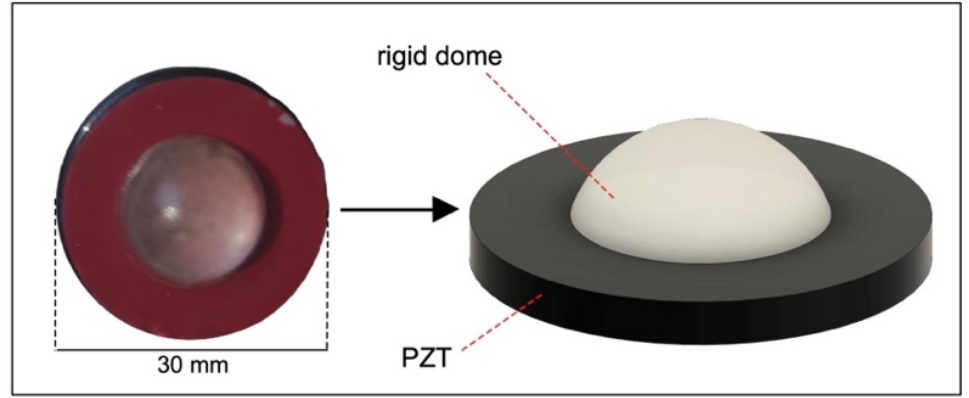
Figure 6. Actual realization of the PZT sensor and its 3D rendering.